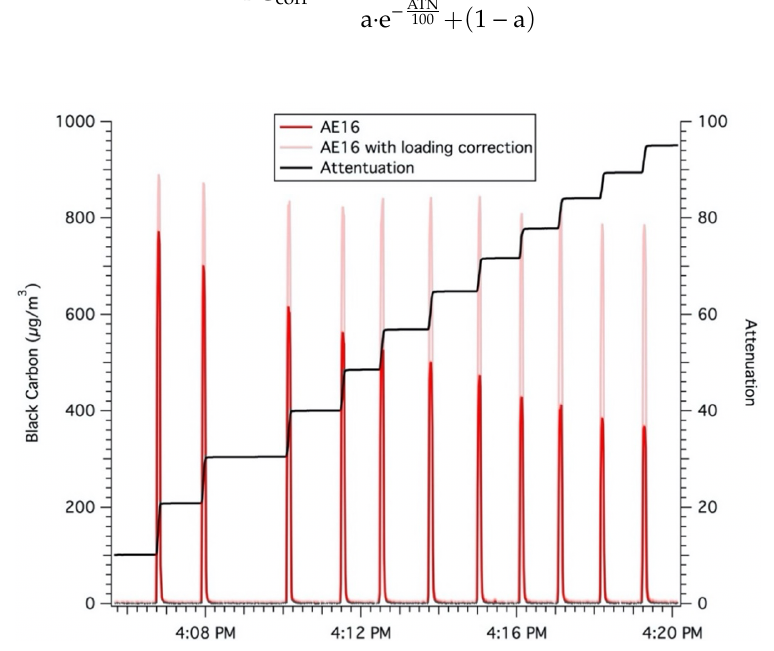
Figure A2. BC concentrations measured during controlled laboratory experiments with a steady emission source, with corresponding filter attenuation. After the AE16 data is post-processed using Equation (A1) (pink).